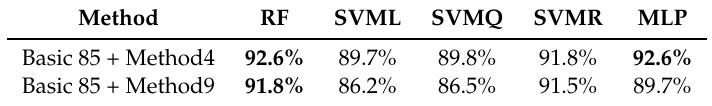
Table 2. Classification accuracy for speed changes for combined feature vectors: 85 basic features and lines, calculated using 2 best performing methods. The three best results are shown in bold.